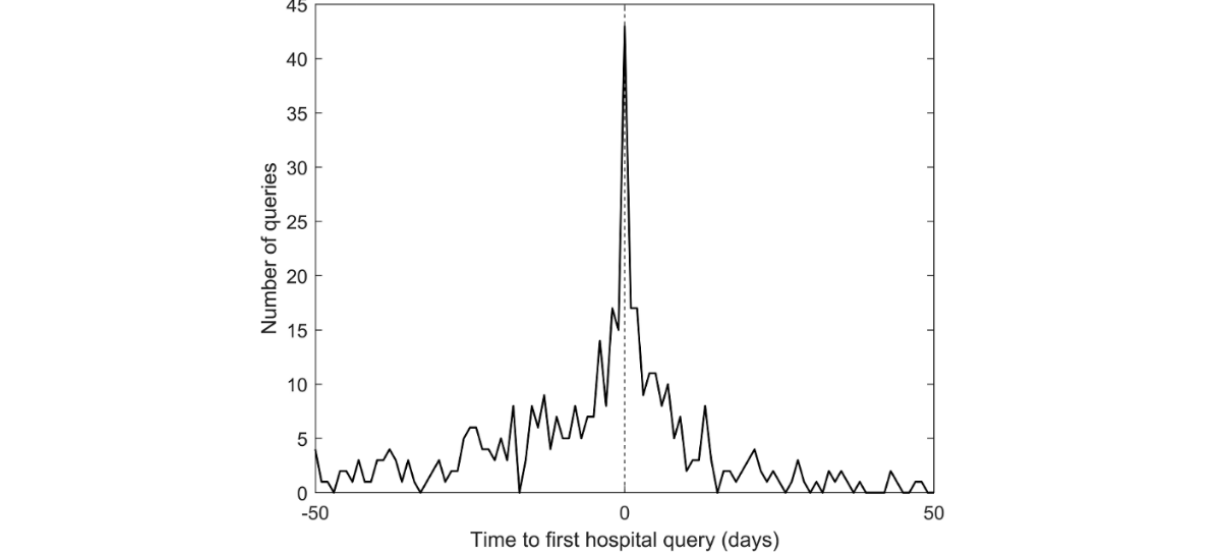
Figure 1. The time from the first query about a hospital and the time of the first query indicating the condition. Negative times indicate that the first query to a hospital was made prior to the first query about the disease. The figure shows data for endometrial cancer, esophageal cancer, and